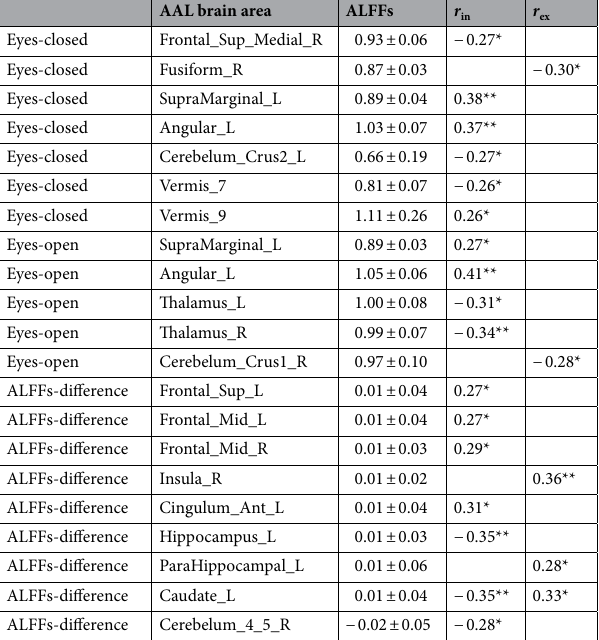
Table 2. Correlations between ALFFs/ALFFs-difference with the PDP. r in is the correlation between ALFFs/ ALFFs-difference and the correct inclusion-task response; r ex is the correlation between ALFFs/ALFFs- difference and the incorrect exclusion-task response. * p < 0.05, ** p < 0.01, *** p < 0.001. The same